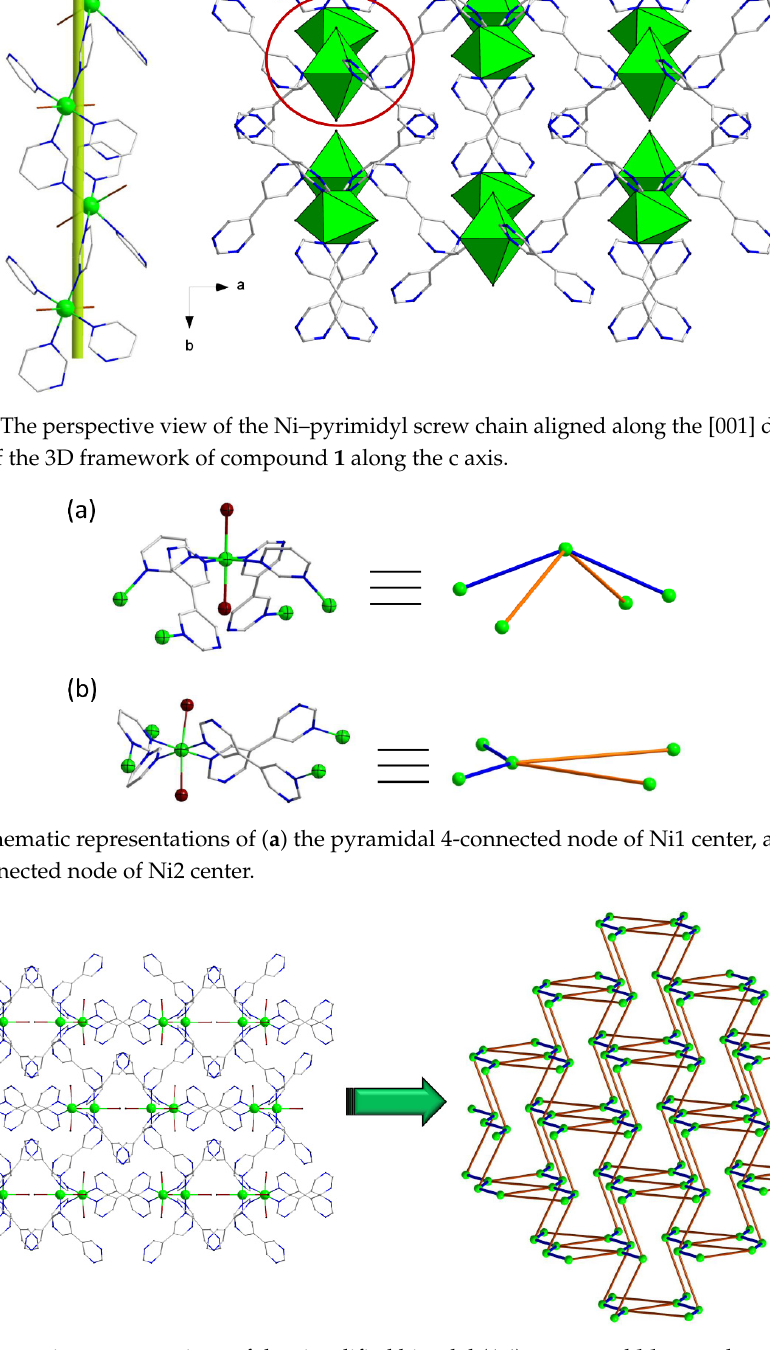
Figure 4. Schematic representations of the simplified binodal (4,4)-connected bbe topologcal network of compound 1 ; the twisted syn - μ -bpym ligands are represented by blue sticks, planar anti - μ -bpym ligands are represented by orange sticks, and Ni centers are represented by blue spheres.